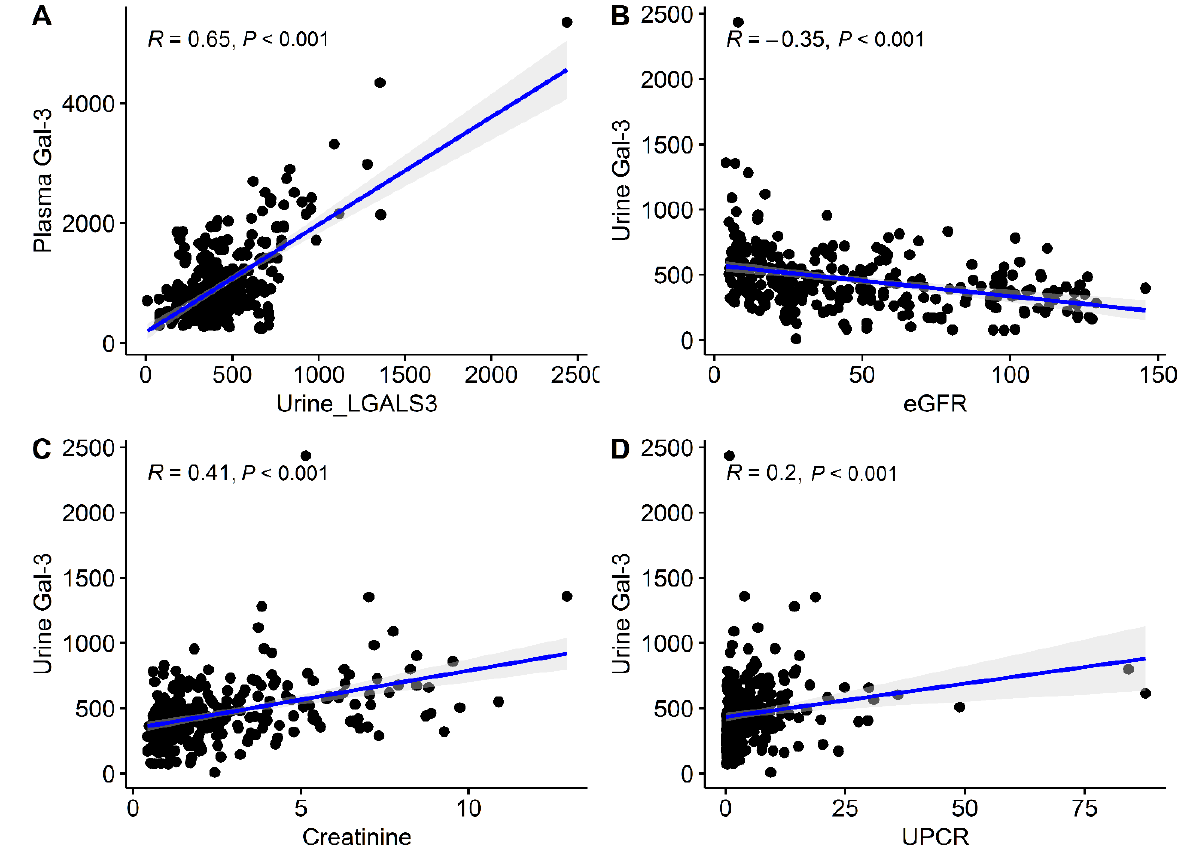
Figure 1. Correlation between urinary Gal-3, plasma Gal-3, eGFR, creatinine, and UPCR. ( A ) Corre- lation plots between urinary Gal-3 and plasma Gal-3 levels. ( B ) Correlation plots between urinary Gal-3 level and eGFR. ( C ) Correlation plots between urinary Gal-3 level and creatinine. ( D ) Corre- lation plots between urinary Gal-3 level and UPCR. Abbreviations : Gal-3, Galectin-3; eGFR, estimated glomerular filtration rate; UPCR, spot urine protein–creatinine ratio. Table 1. Clinical characteristics of the study participants stratified by tertiles of urinary